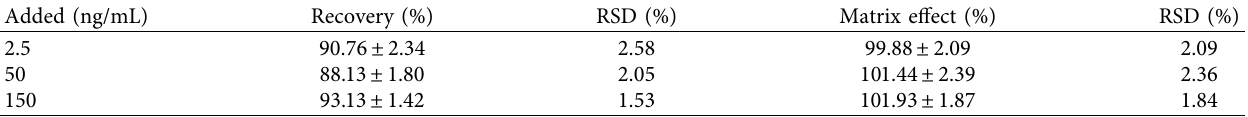
Table 3: Recovery and matrix effect of tropifexor from Beagle plasma ( n �